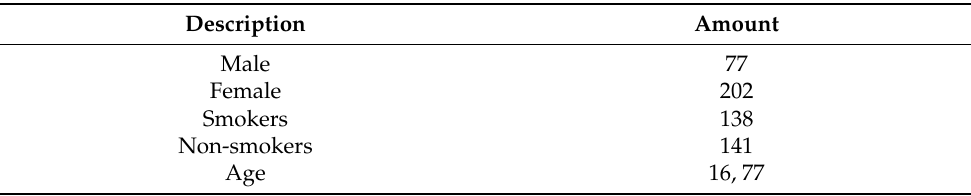
Table 1. Basic descriptive information of the patients.